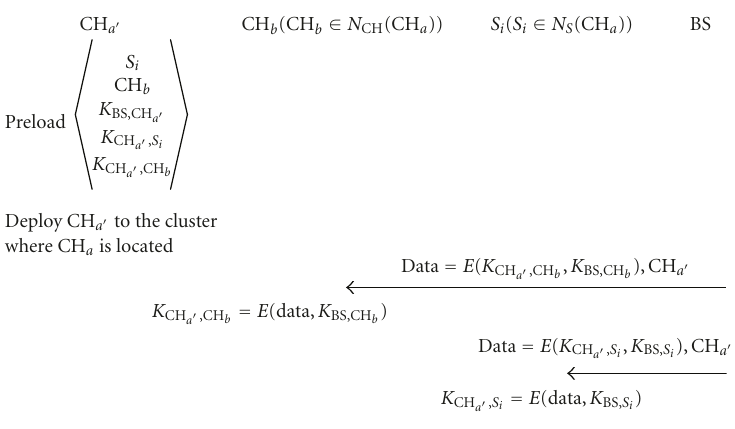
Figure 3: Protocol illustration of adding a new cluster head when BS is